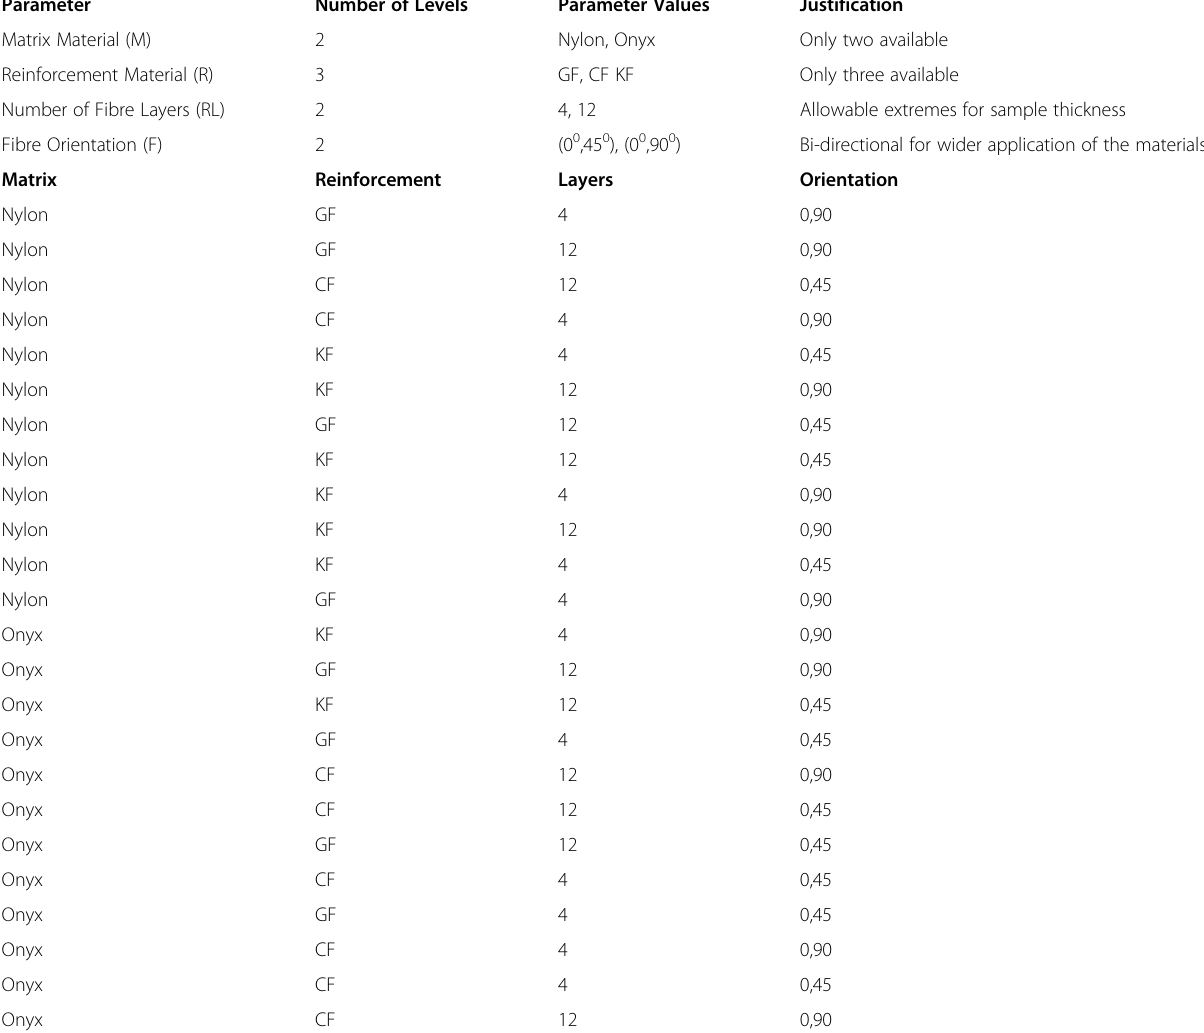
Table 2 Parameters Employed and Levels Set for Sample Manufacture Parameter